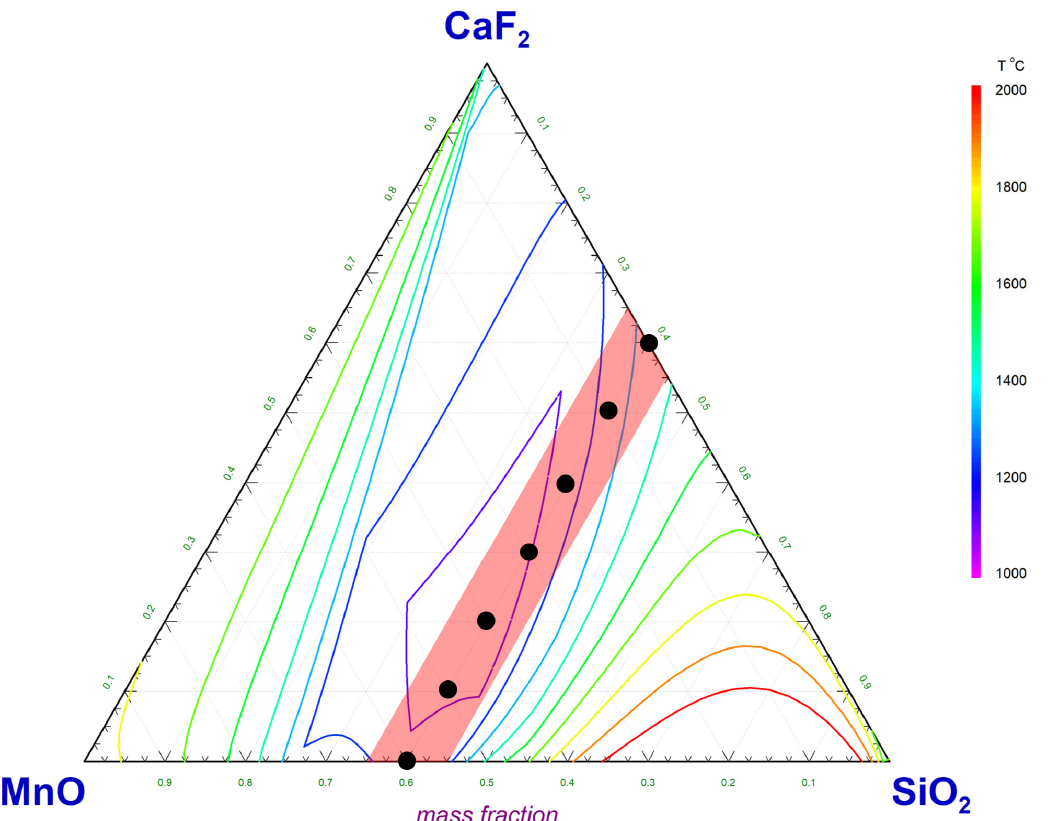
Figure 1. Isotherm projection graph for CaF 2 ‐ SiO 2 ‐ MnO melts.